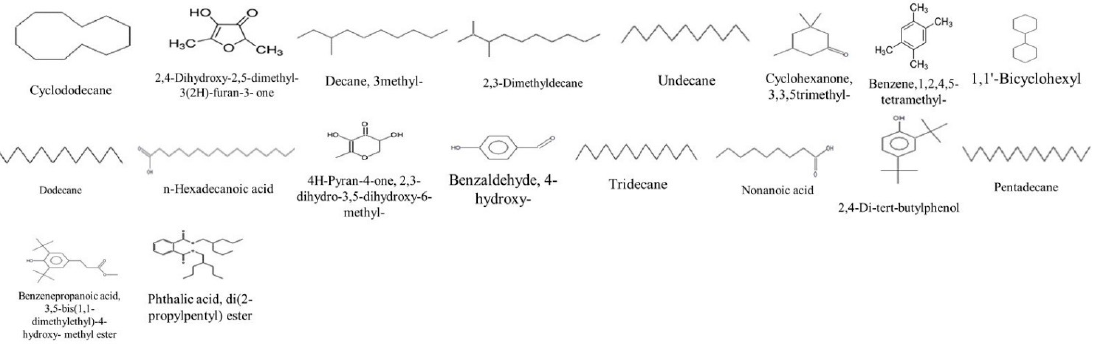
Molecules 2022 , 27 , x FOR PEER REVIEW Figure 4. Compounds firstly identified in V. vinifera Stem part by GC-MS (before derivatization).